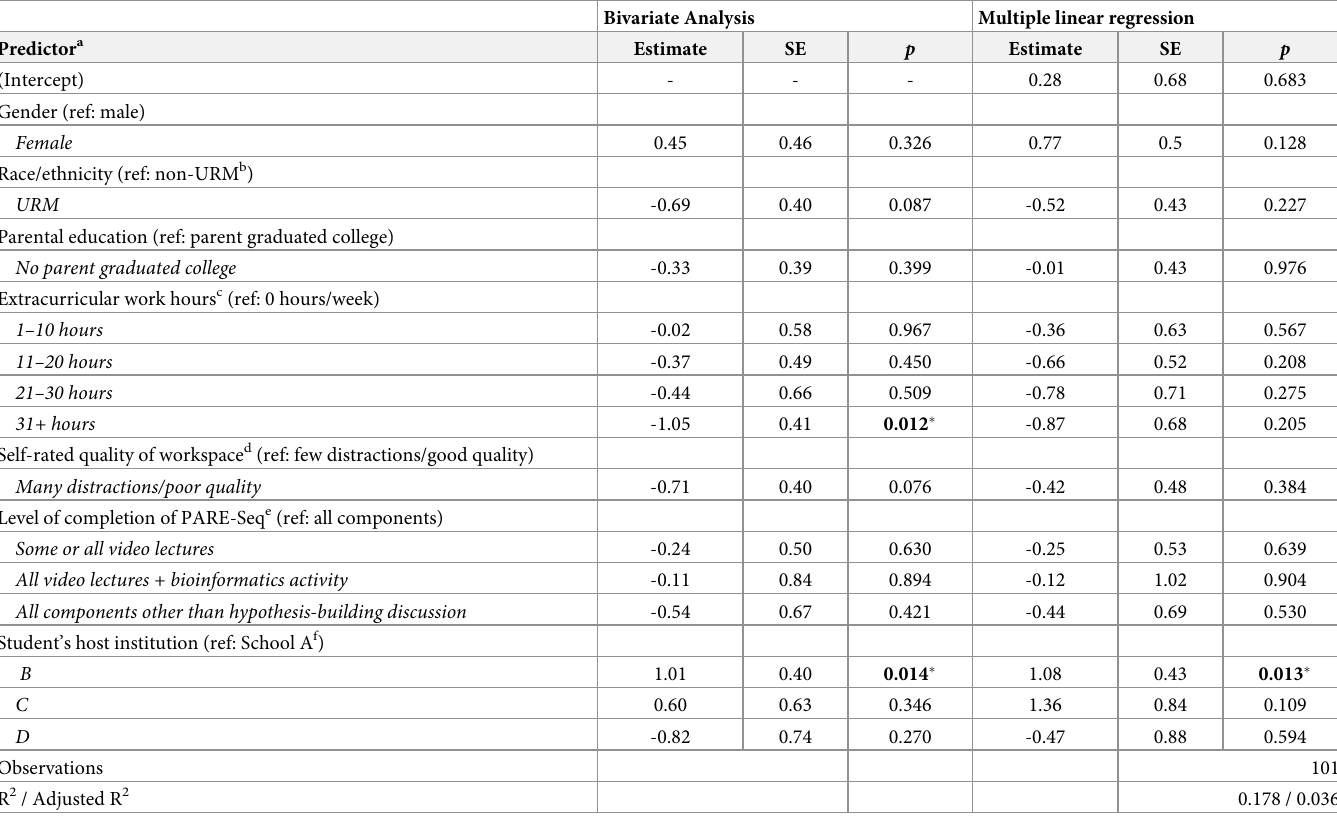
Table 7. Bivariate associations and multiple linear regression model of the effect of student sociodemographic characteristics on learning